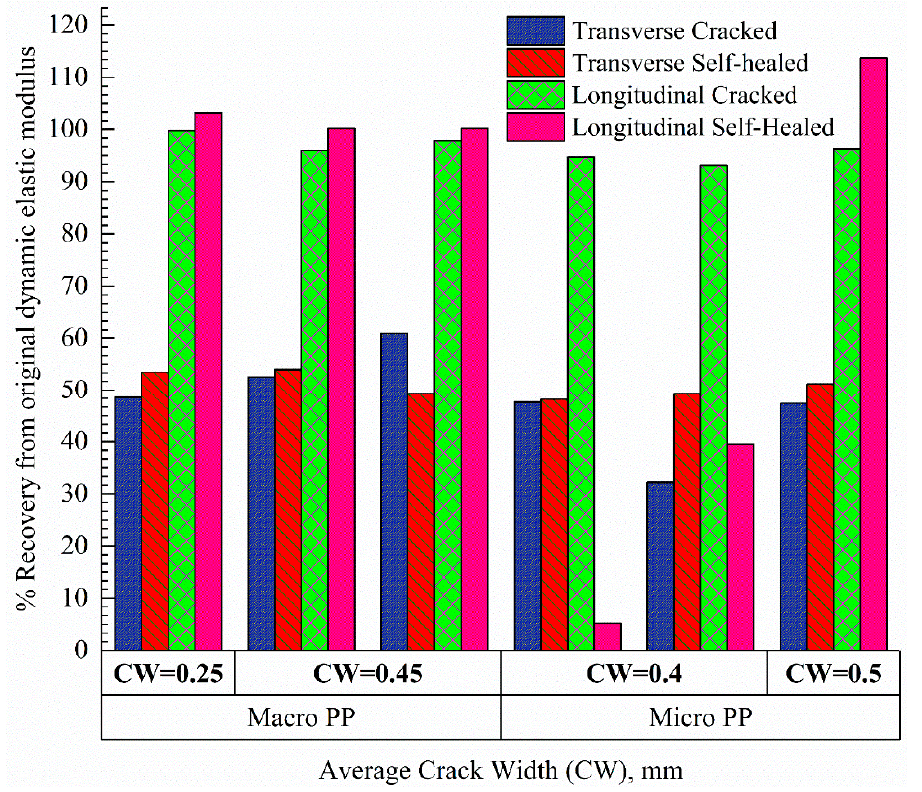
Figure 9. Recovery of dynamic elastic modulus in transverse and longitudinal mode as a function of